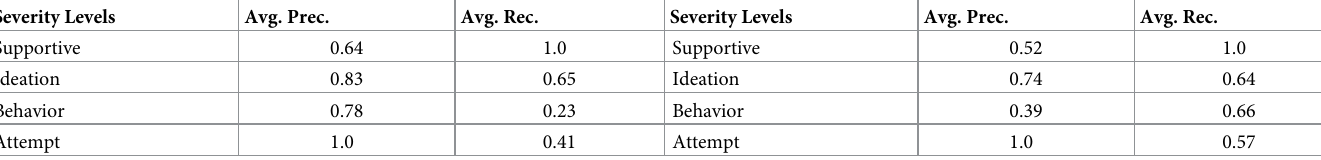
Table 7. Suicide risk severity category-based performance evaluation of TvarM (left) and TinvM (right) approaches. Severity Levels Avg.